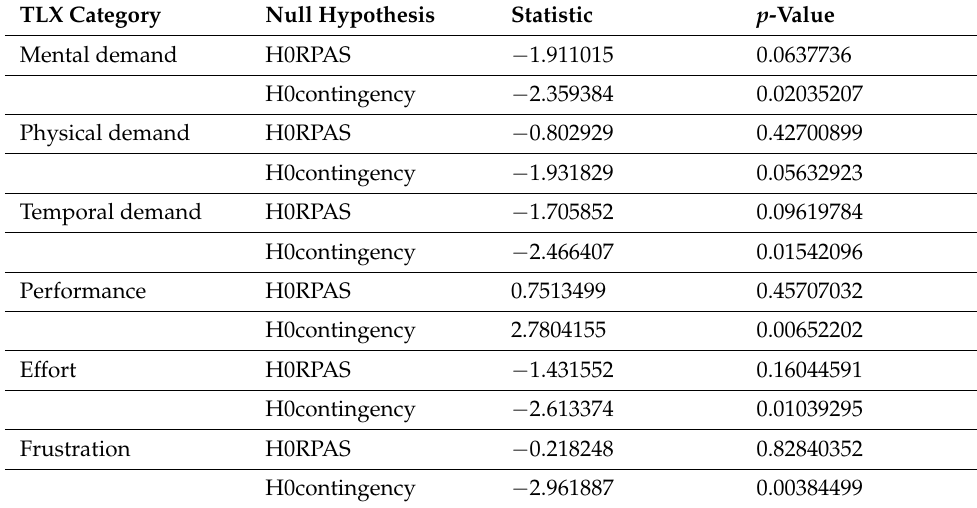
Table 9. t -test statistical analysis for each of the six TLX Table 9. T-test statistical analysis for each of the six TLX categories.